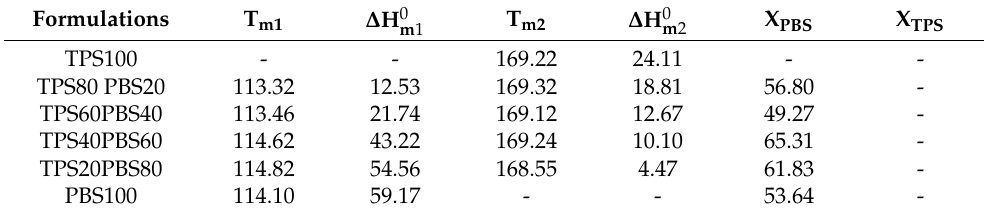
Figure 3. DSC curves of PHA/PBS blends. Table 5. Transition temperature and crystallinity of TPS/PBS blends.